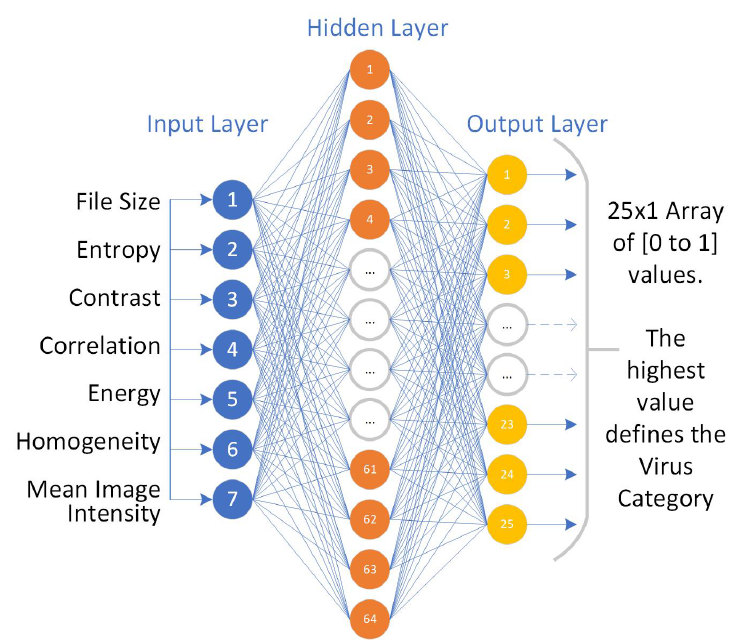
Figure 5. Single ANN